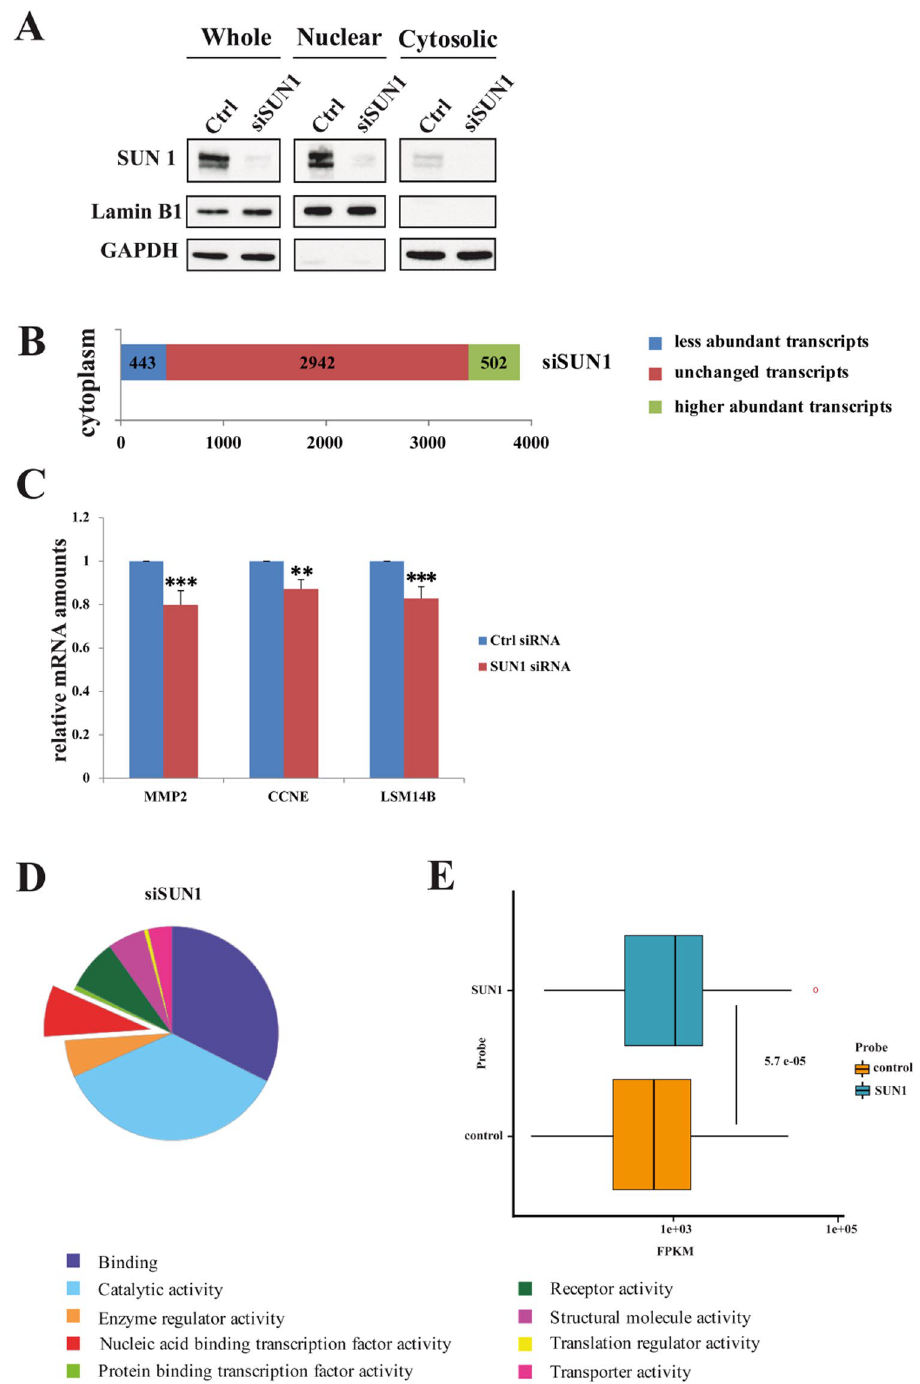
Figure 3. Whole genome expression profile of HeLa cells depleted of SUN1. ( A ) Fractionation of control and SUN1 knockdown cells into nuclear and cytosolic fraction. LaminB is a marker for the nucleus, GAPDH a marker for the cytosol. ( B ) The total number of less abundant, unchanged and higher abundant transcripts in the cytoplasm compared to control knockdown (Ctrl) identified in the analysis is shown. The data result from three independent knockdown experiments. ( C ) Validation of the results for three transcripts by q-RT PCR. MMP-2, matrix metalloproteinase-2; CCNE, cyclin E1; LSM14B, protein LSM14 homolog B. P value ** < 0.01, *** < 0.001. ( D ) GO molecular function categorization of the mRNAs depleted in the cytoplasm of cells with reduced SUN1 levels. ( E ) Genes, whose transcripts are less common in the cytoplasm of SUN1 knockdown than in the control are more highly expressed in the control than the average gene. SUN2 knockdown was used for comparison (control). The data represent the results of three individual knockdowns. FPKM = Fragments Per Kilobase of exon per Million reads mapped. The graphics was produced using ggplot implemented in R. The Wilcoxon signed-rank test was used to test for the significance of the